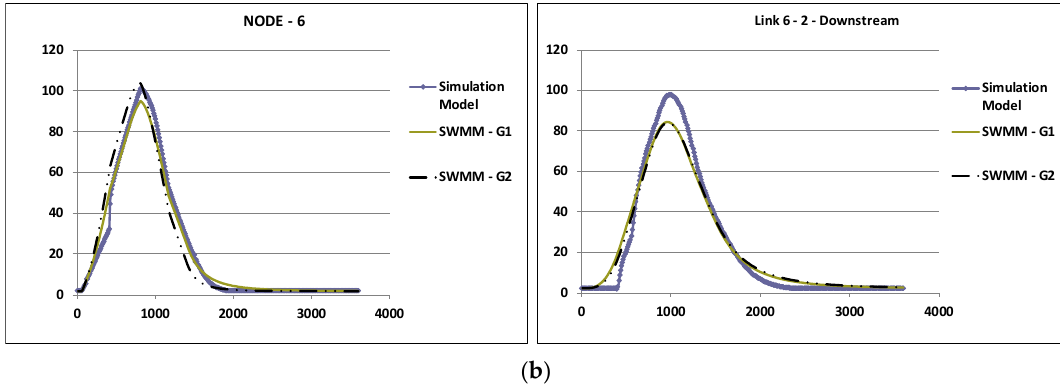
Figure 7. Comparison of the flow hydrographs in the nodes and in the downstream end of the links for the dendritic network tested with respect to (i) the implicit simulation model considering each link separately and the normal depth as the link downstream boundary condition; (ii) the SWMM explicit model for the network as a whole considering a free discharge and the conduits aligned by the internal crown, SWMM–G1; and (iii) aligned by the invert elevation, SWMM–G2. ( a ) Precipitation of 7.5 min. ( b ) Precipitation of 12.5 min. Graph axes: horizontal—time (s); vertical—volumetric flow rate (L/s). Table 3. Comparison of the maximum volumetric flow rates obtained in each link for the test network and for periods of precipitation of 7.5 and 12.5 min, applying the simulation model considering each link separately and the normal depth as the link downstream boundary condition, and those obtained using SWMM for the network as a whole considering a free discharge and the conduits aligned by the internal crown, SWMM–G1, and by the invert elevation, SWMM–G2. Q Max Upstream (L/s) Tp = 7.5 Min. Tp = 12.5 Min. Links 5-4 Sim.